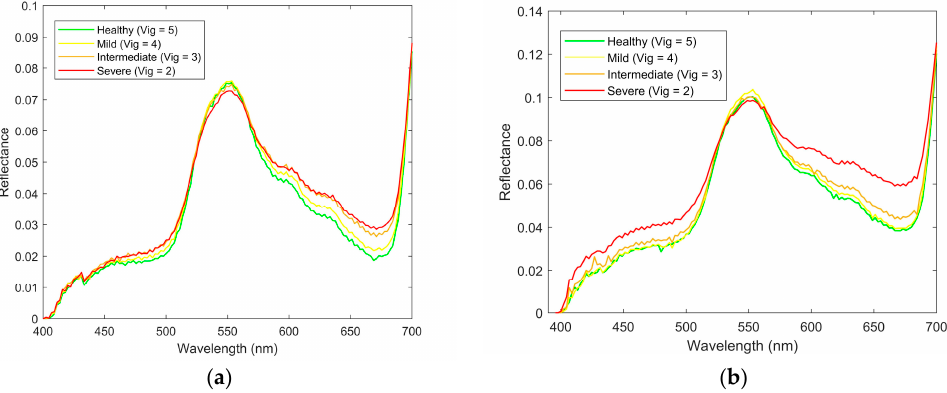
Figure 14. Mean spectral signature for different levels of vigour of the grapevine for the V. vinifera Chardonnay variety measured in ( a ) December 2016 and ( b ) February 2017 for wavelengths from 400 nm to 700 nm.